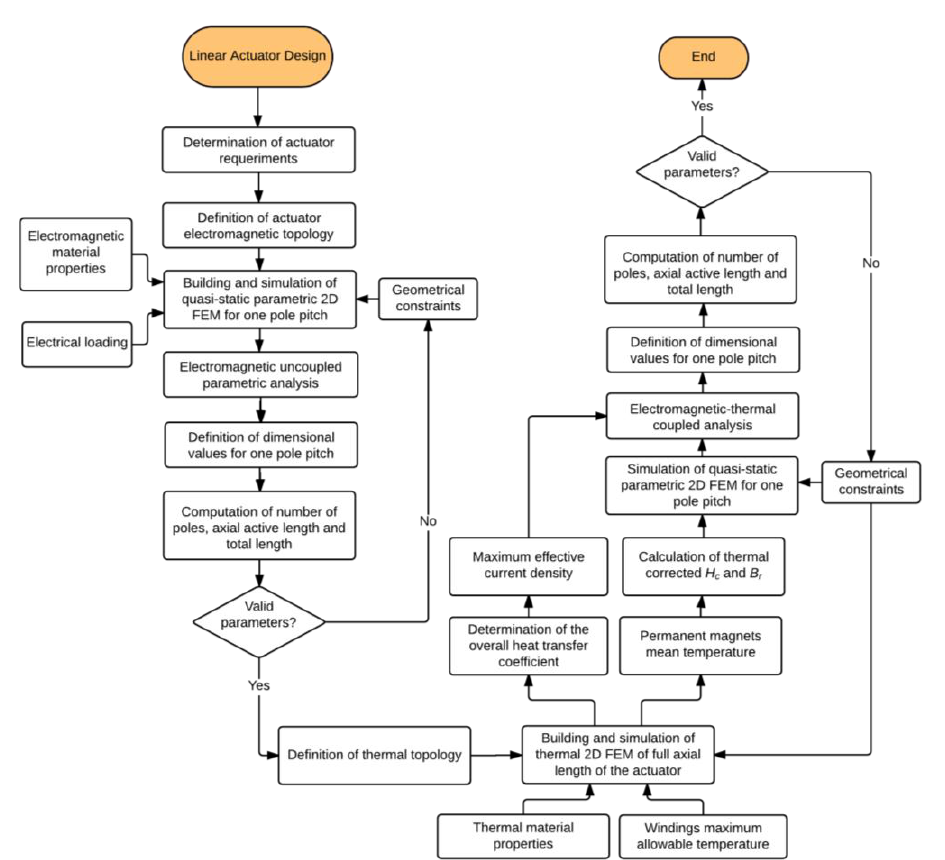
Figure 2. Flowchart of the proposed design methodology of linear cylindrical actuators with electromagnetic-thermal coupling.